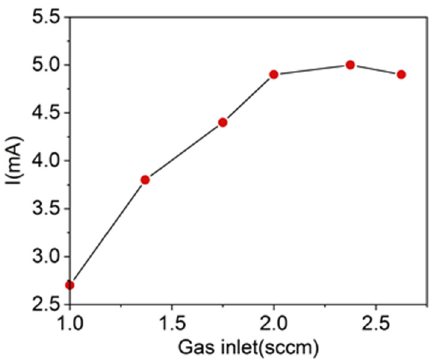
Figure 12. Extraction beam current under the different hydrogen gas consumption rates (standard